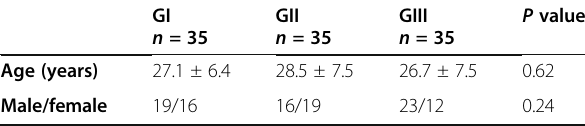
Table 1 Baseline characteristics of the studied groups